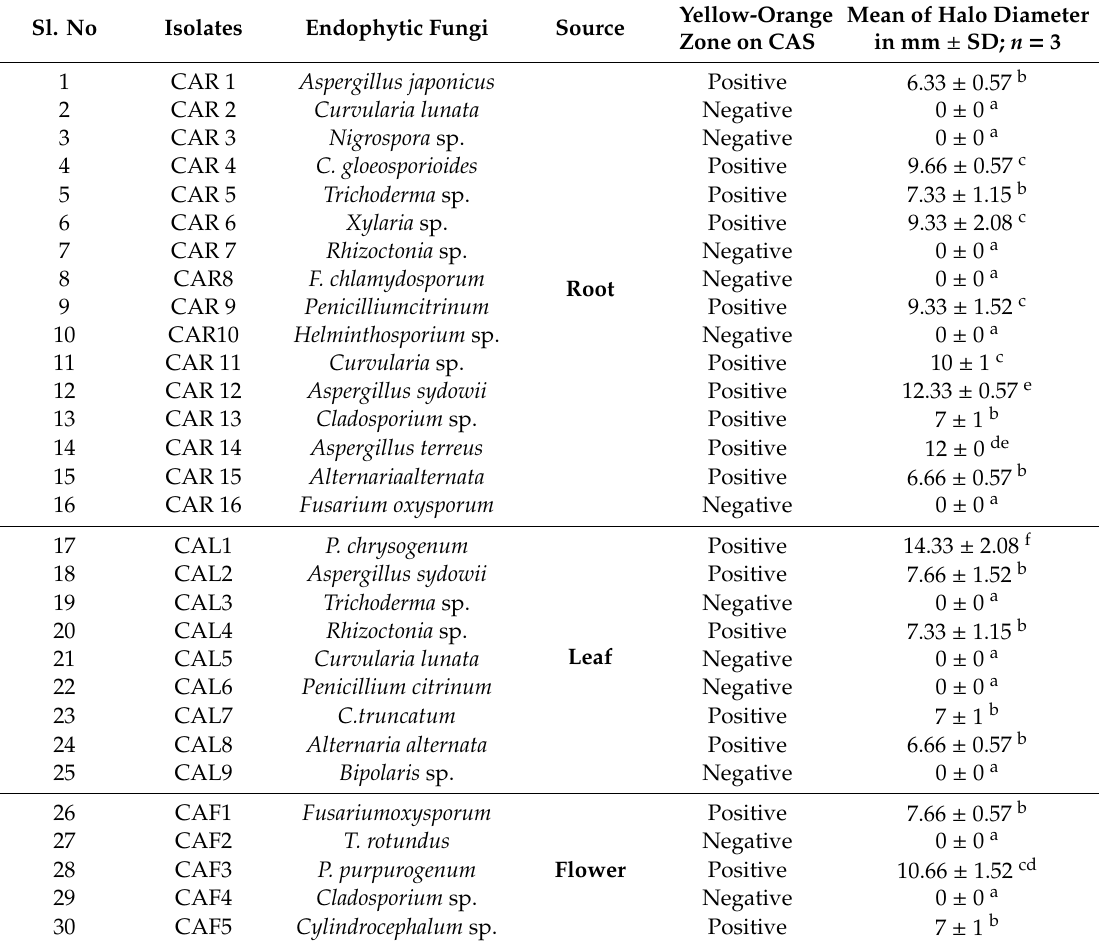
Table 1. Screening for siderophore production by endophytic fungi of Cymbidium aloifolium on Chrome Azurol S Agar